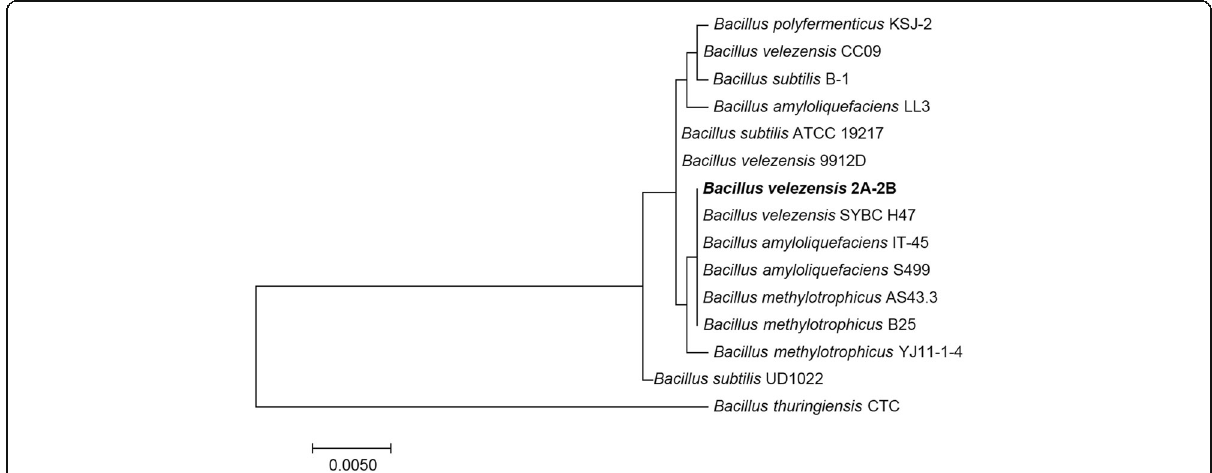
Fig. 2 Phylogenetic tree with B. velezensis 2A-2B showing its relationships with species of the Bacillus genus. The tree was constructed based on 16S rRNA gene alignments in MEGA7 [11] applying the Neighbor-join method, and rooted using Bacillus gibsoni FJAT-10019 strain as an outgroup